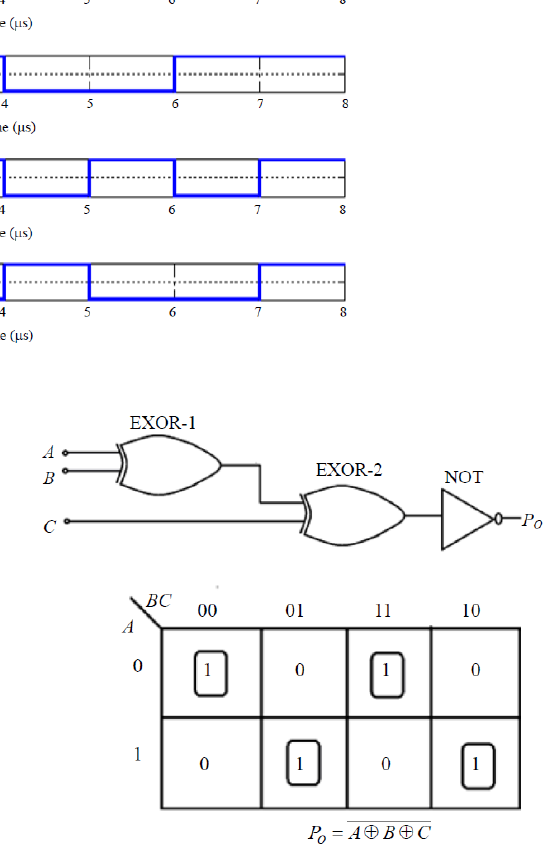
Fig. 6 Digital circuit and K-map of a three-bit-odd-parity generator.